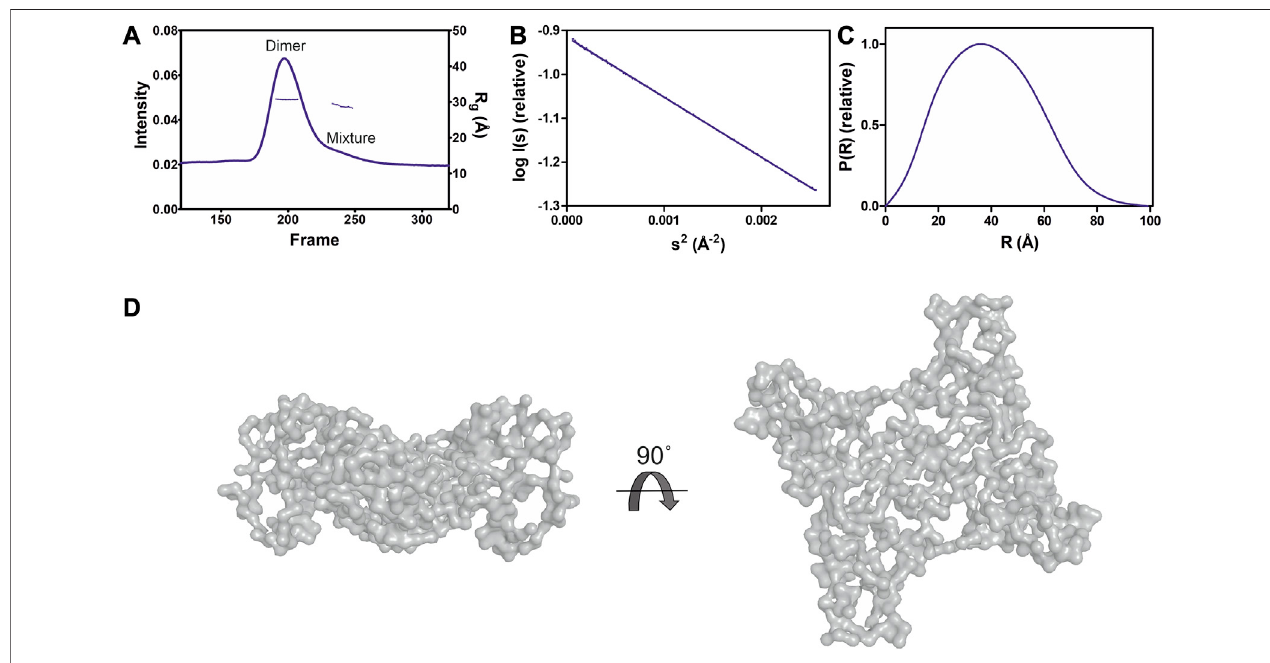
FIGURE 2 | SAXS analysis of GDAP1 Δ 303-358. (A) SEC-SAXS elution pro fi le. R g trace for the dimer and mixture of dimer/monomer peaks is also plotted. (B) Guinier analysis of the dimer data. (C) Distance distribution function for dimer. (D) Two different views of the ab initio chain-like model of dimeric GDAP1 Δ 303-358.